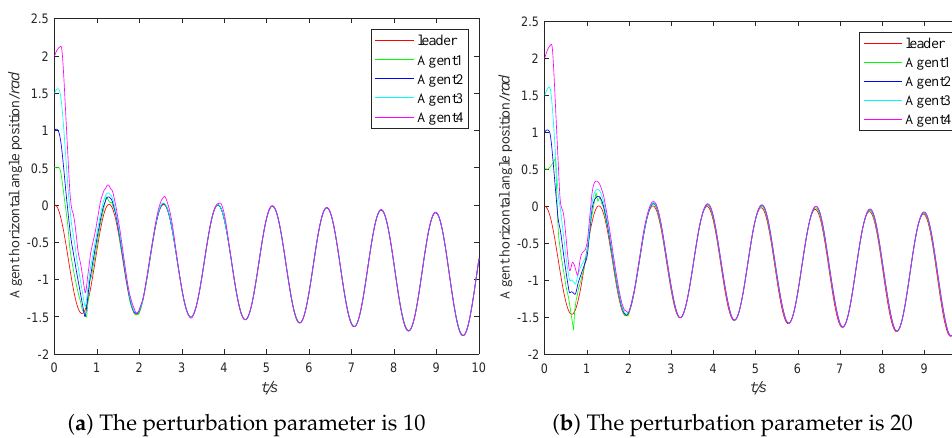
Figure 6. The performance of the system under different non-vanishing